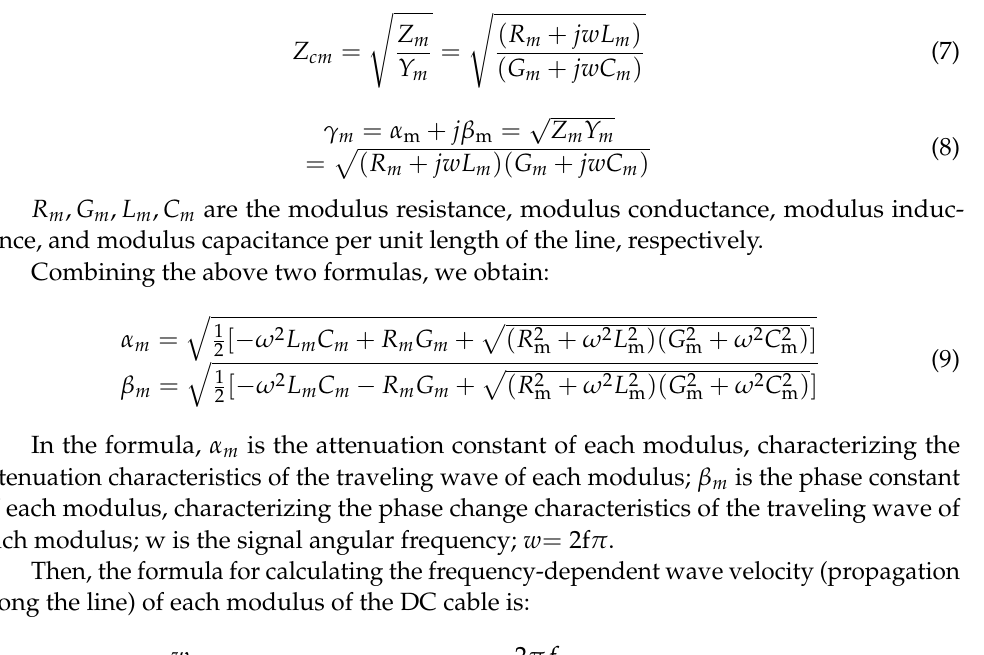
Figure 2. Fault voltage traveling wave grid diagram. In the DC cable, the characteristic impedance (wave impedance) ulus and the modulus propagation coefficient